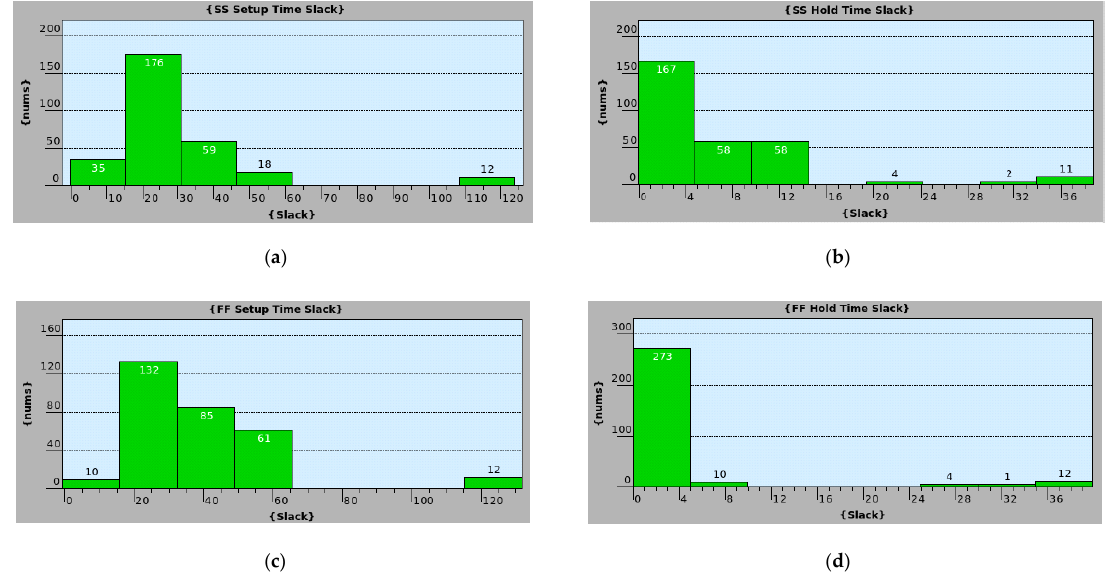
Figure 19. Post-layout static timing analysis (STA): ( a ) setup time slack of the worst case; ( b ) hold